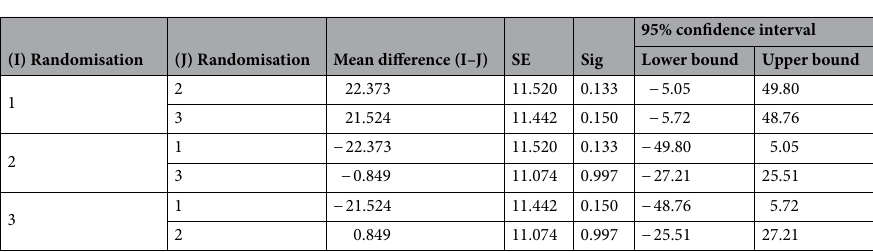
Table 7. Comparison between groups of benzodiazepine (Diazepam equivalent dose) required to achieve first GMAWS = 0 score (one-way ANOVA Tukey test).